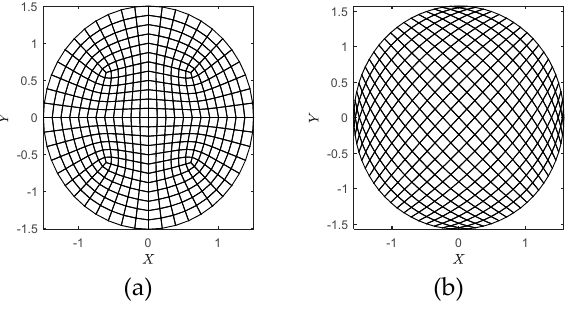
Figure 6. Mesh grids used in calculations: ( a ) grid A; ( b ) grid B.